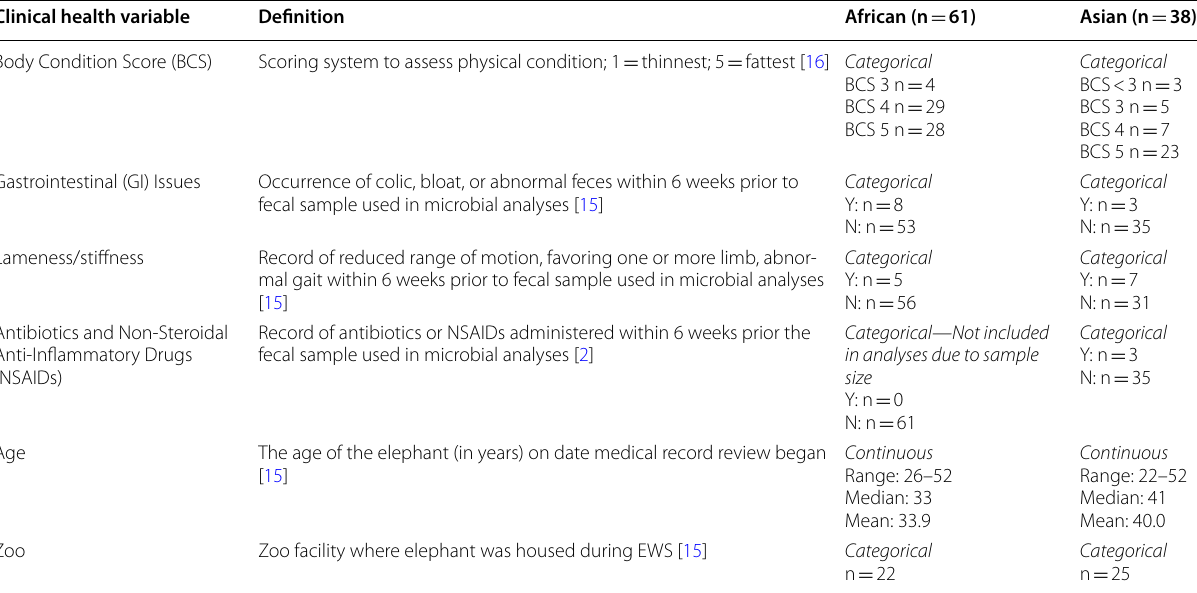
This table details the clinical health variables assessed in a subset of zoos with two or more elephants